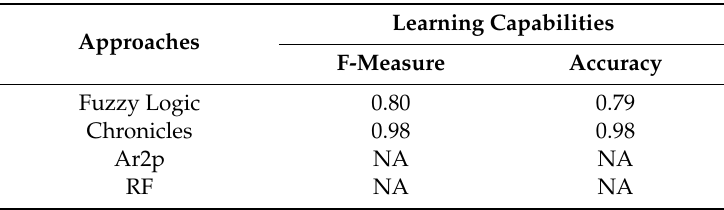
Table 16. Results of the Learning Capabilities with missing data during the testing phase with the data stream.